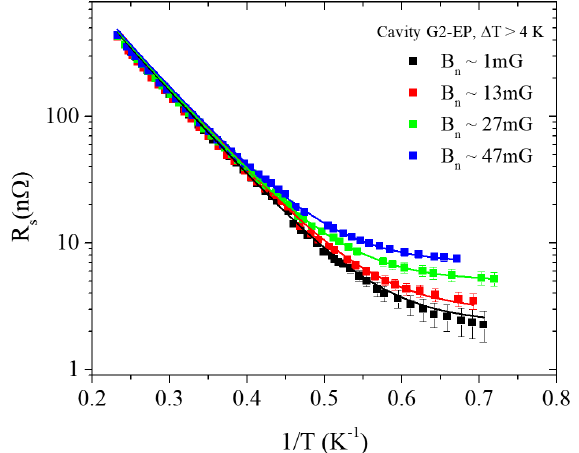
Þ measured at 2.0 K after cooldown with Δ T > FIG. 7. Q 0 ð B p 4 K and B < 5 mG for each cavity and treatment listed in n Table II. The arrows indicate the quench